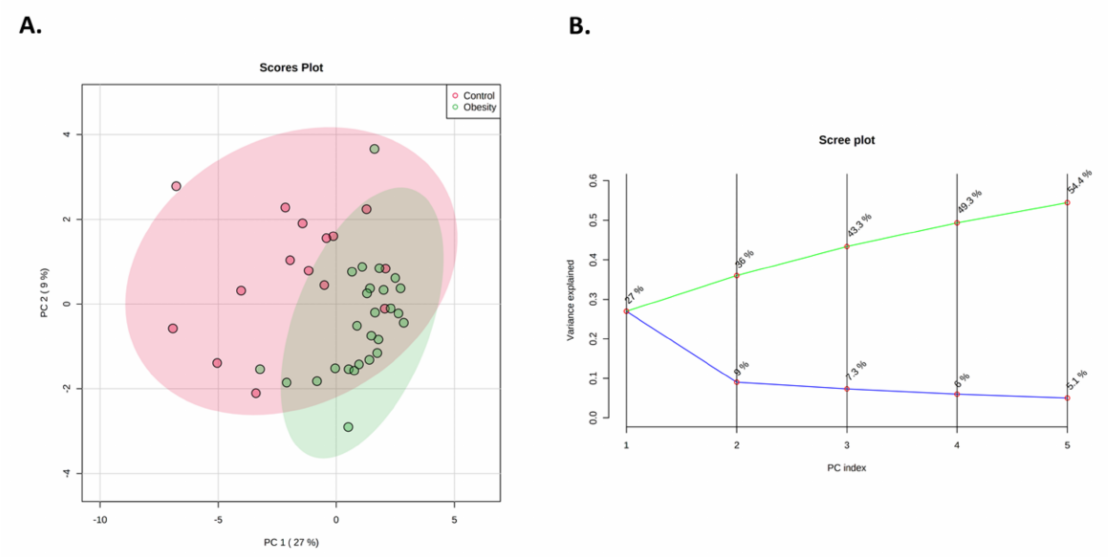
Figure 6. PCA analysis between patient groups. ( A ) Two-dimensional (2D) score plots between PC1 and PC2. Patients with obesity are shown in green, and those without obesity are shown in red. ( B ) Scree plot showing the variance explained by PCs 1 −